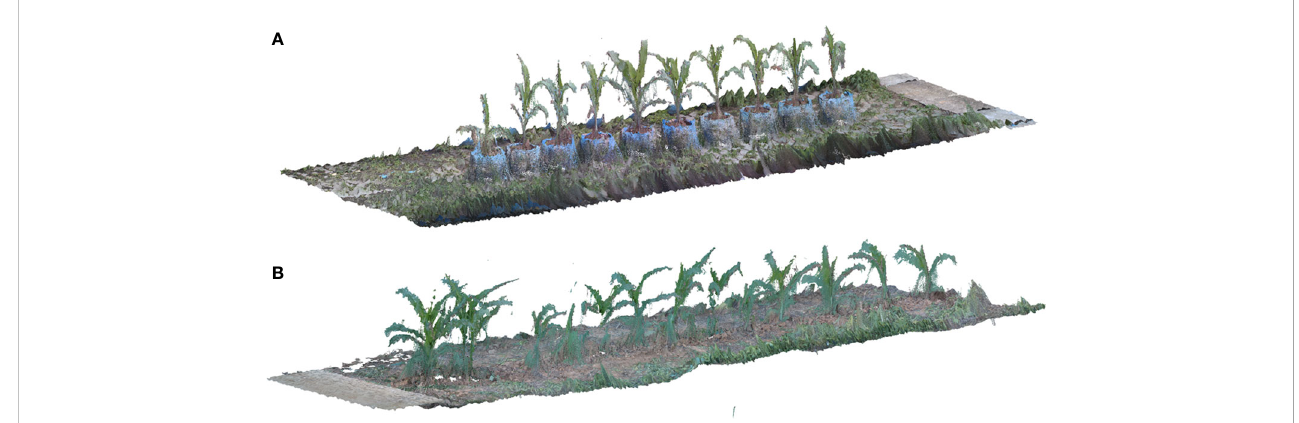
FIGURE 4 Results of crop row point cloud reconstruction (A) Reconstruction result of maize planted in pot (B) Reconstruction result of maize planted in the fi